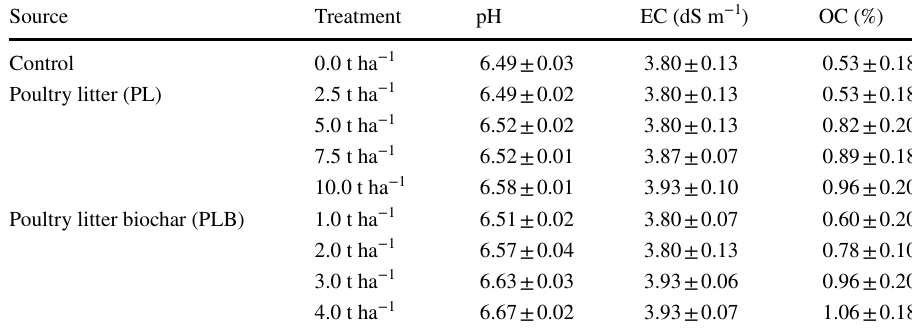
Data represent the average ± the standard deviation ( n